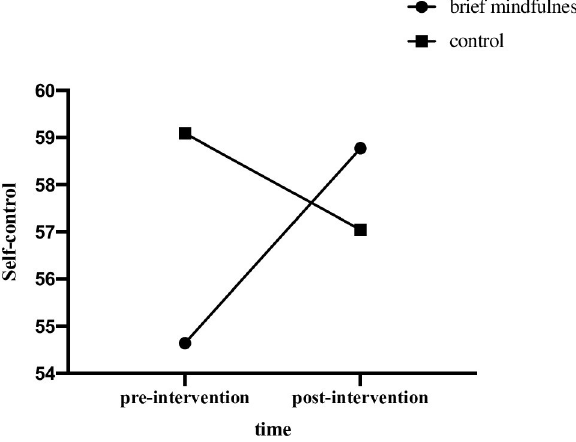
Fig 3. Self-control scores of two groups in pre- and post-